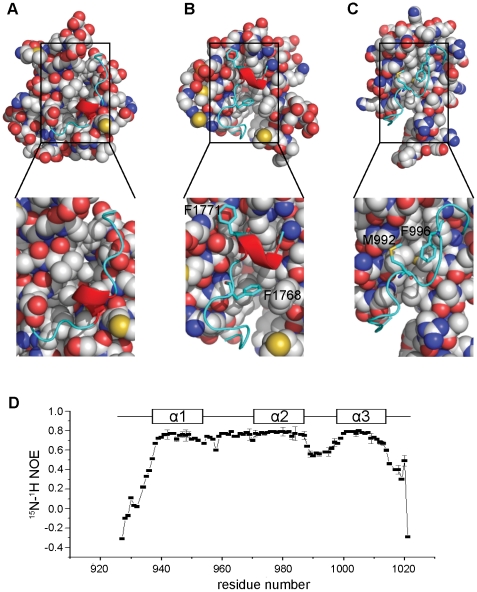
Conformation mobility of loop-2.(A) Type II actinorhodin PKS ACP (PDB ID: 1AF8) that contain mainly small residues in loop-2. (B) Type I NSAS PKS ACP (PDB ID: 2KR5) with the two bulky residues (Phe1768 and Phe1771) highlighted (C) meACP with the two bulky residues (Phe996 and Met992) packed against the hydrophobic pocket highlighted. (D). 1H-15N NOE plot of apo-meACP acquired at an 800 MHz spectrometer at 25°C. The positions of the helices are indicated.